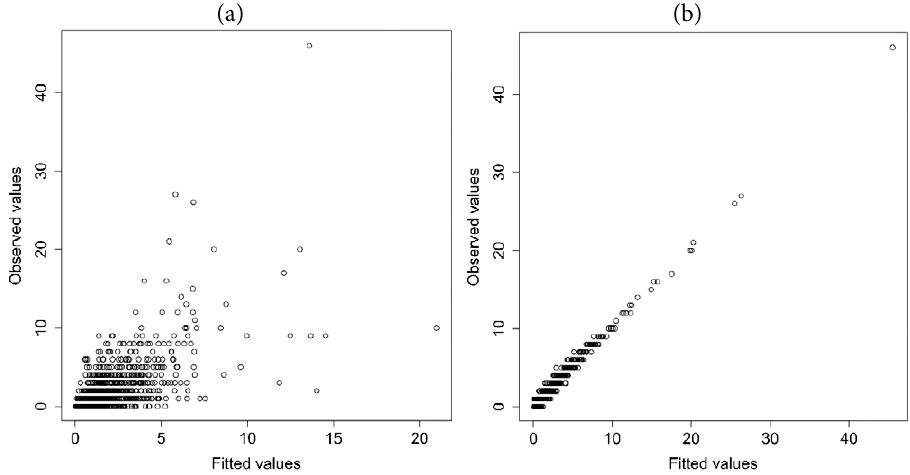
Figure 3 . Plots of observed and fitted values for (a) Poisson regression model and (b) quasi-Poisson CAR- HGLM model based on a 3-km-size grid, Marche